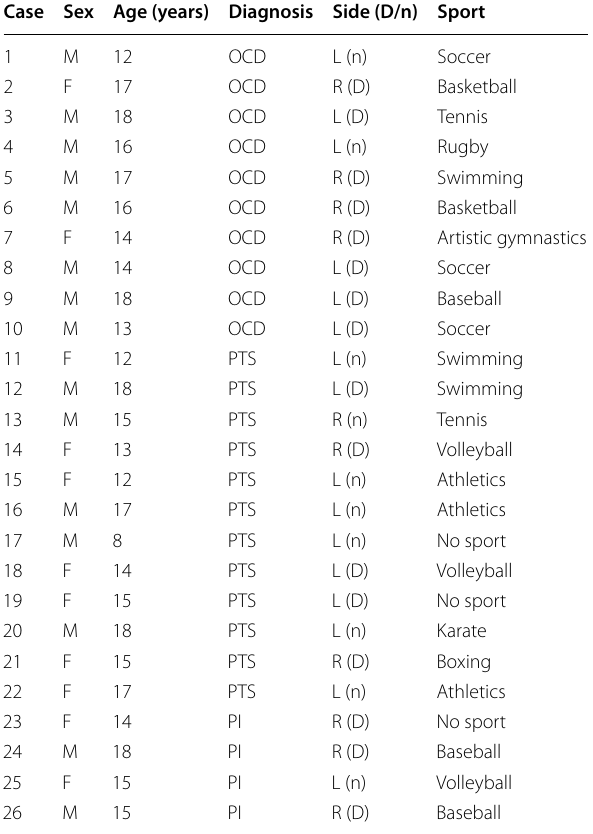
Table 1 Demographic and anamnestic data of the study